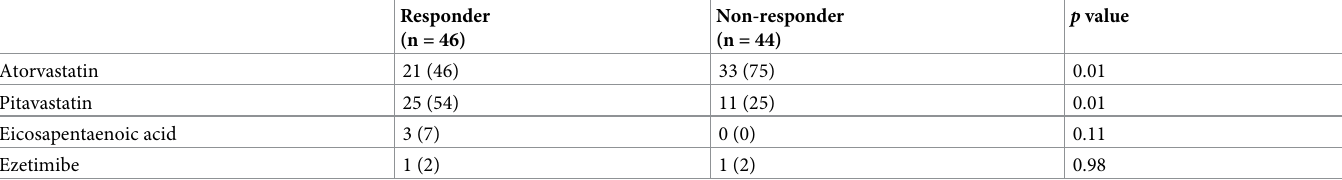
Table 2. Lipid modifying drugs at